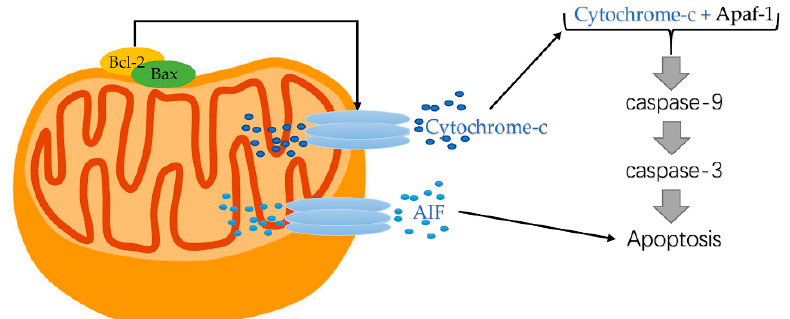
Figure 3. Cytochrome-c released from mitochondrial. Cyt c released from mitochondria enters the cytoplasm, resulting in blocked respiratory chain and electron transport of mitochondria, reduced energy supply of cells, and the conformational changes of mitochondria. Cyt c forms apoptotic bodies and participates in the apoptosis pathway of Caspase cells.